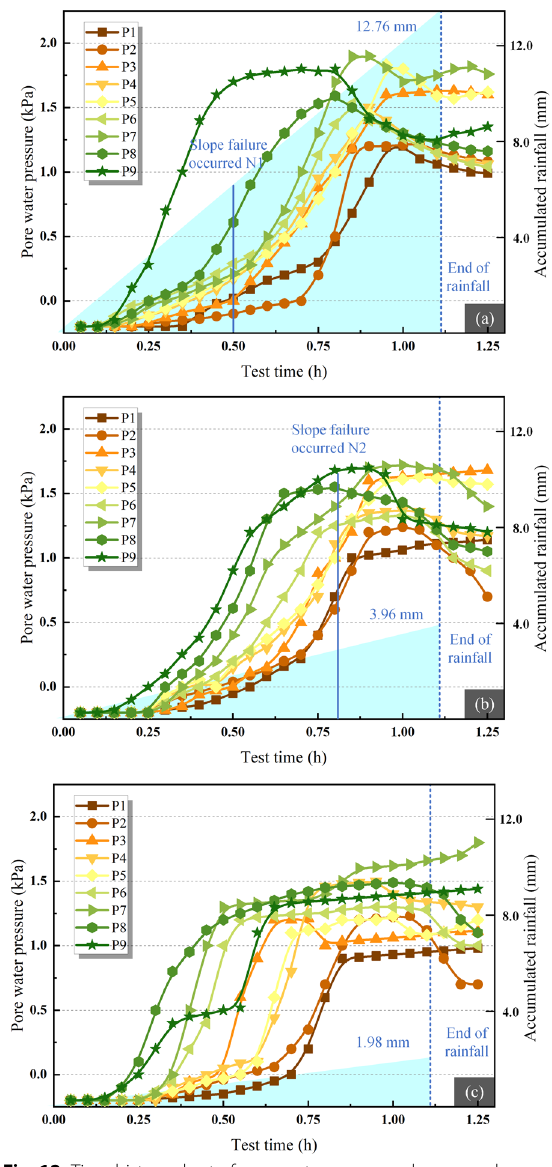
Fig. 12 Time history chart of pore water pressure change under different rainfall intensity a N1, b N2, c